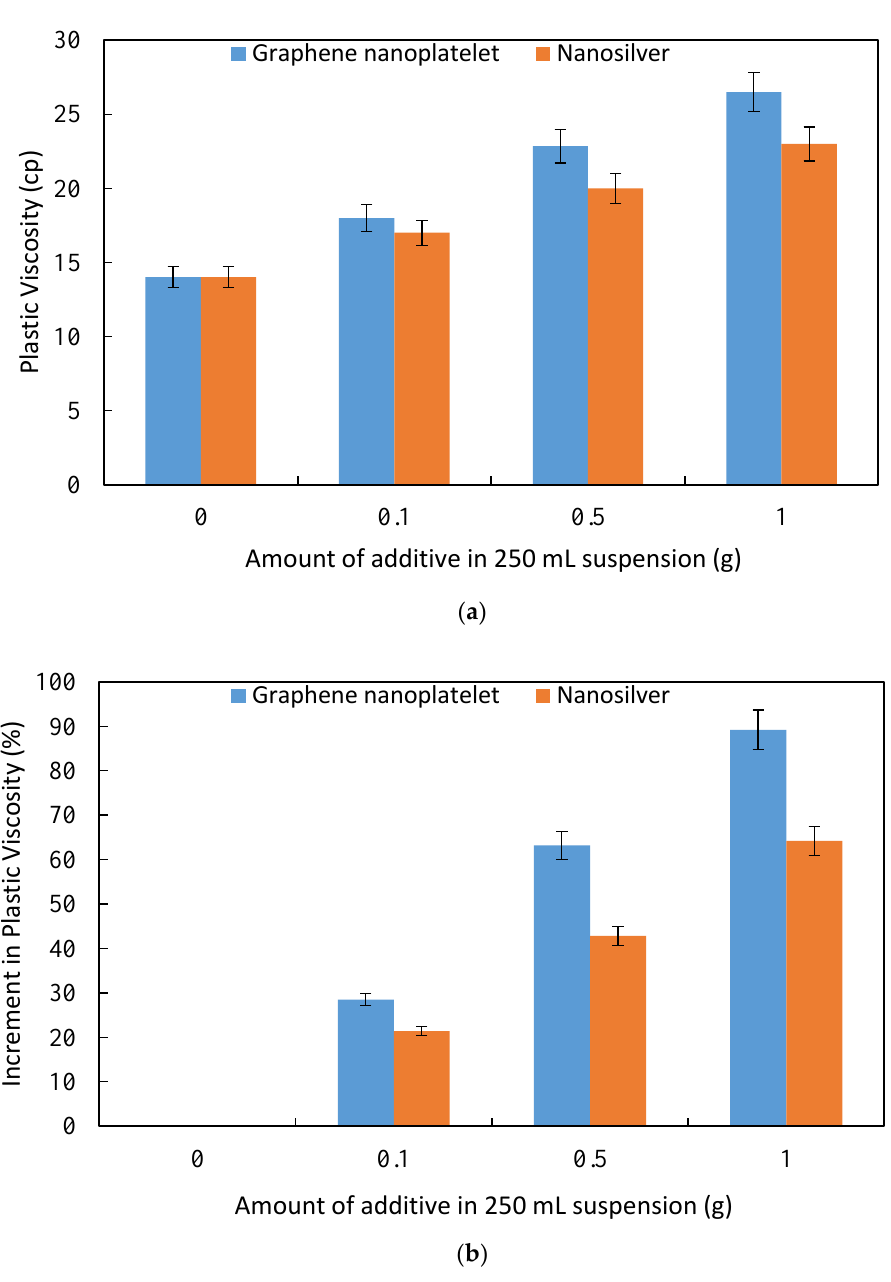
Figure 4. Plastic viscosity (PV) measurement of water-based muds with 5% error bar. ( a ) PV measurements, and ( b ) PV percent increment when graphene nanoplatelet and nanosilver are